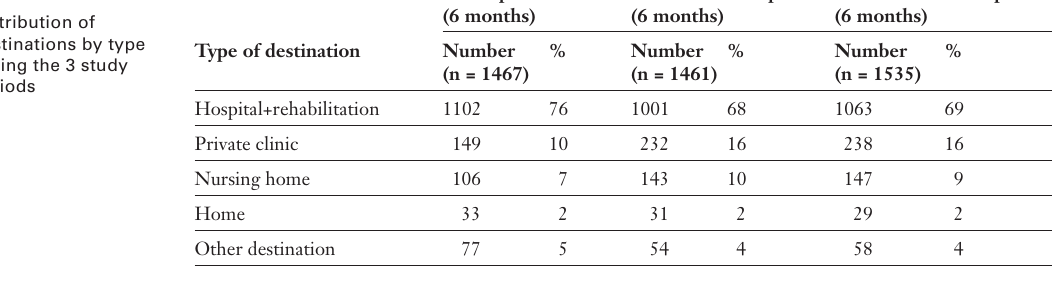
Distribution of destinations by type during the 3 study